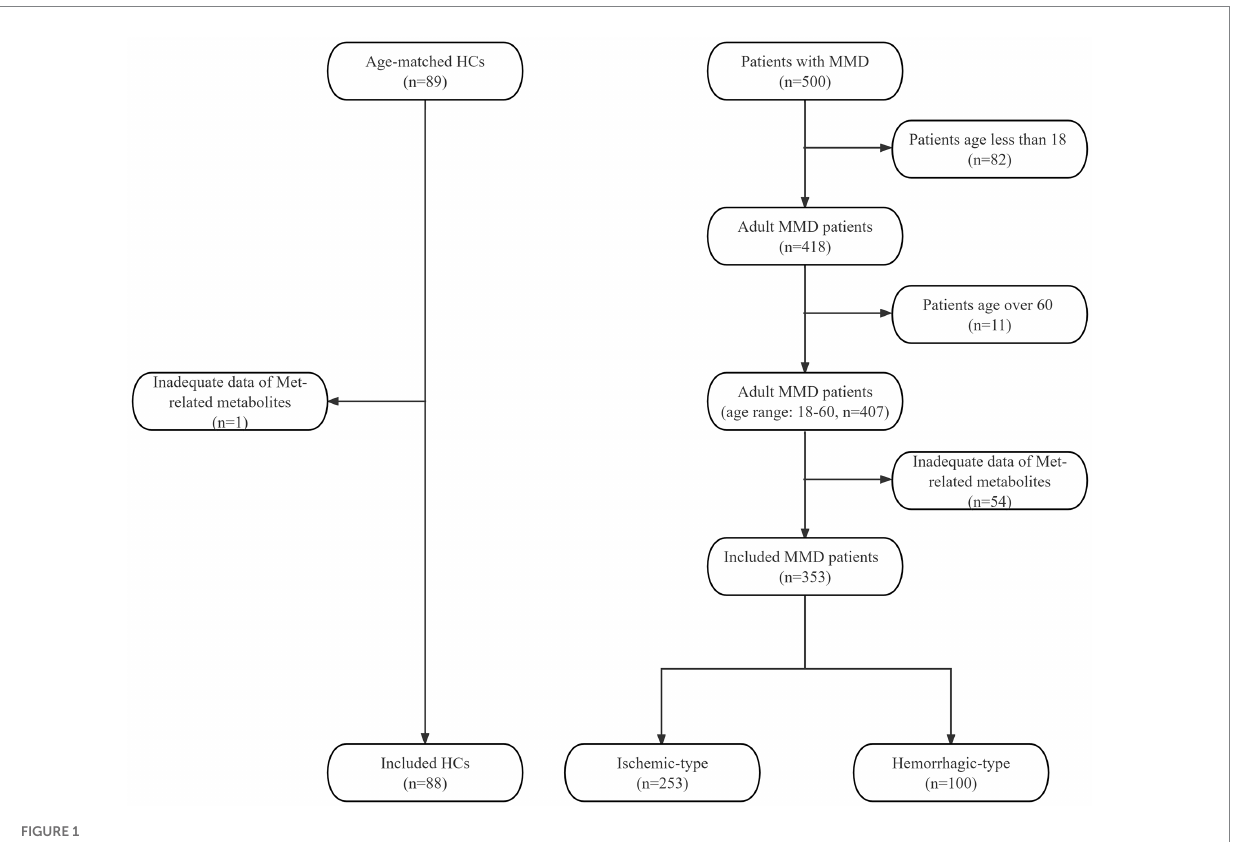
FIGURE 1 Flowchart of the study participant